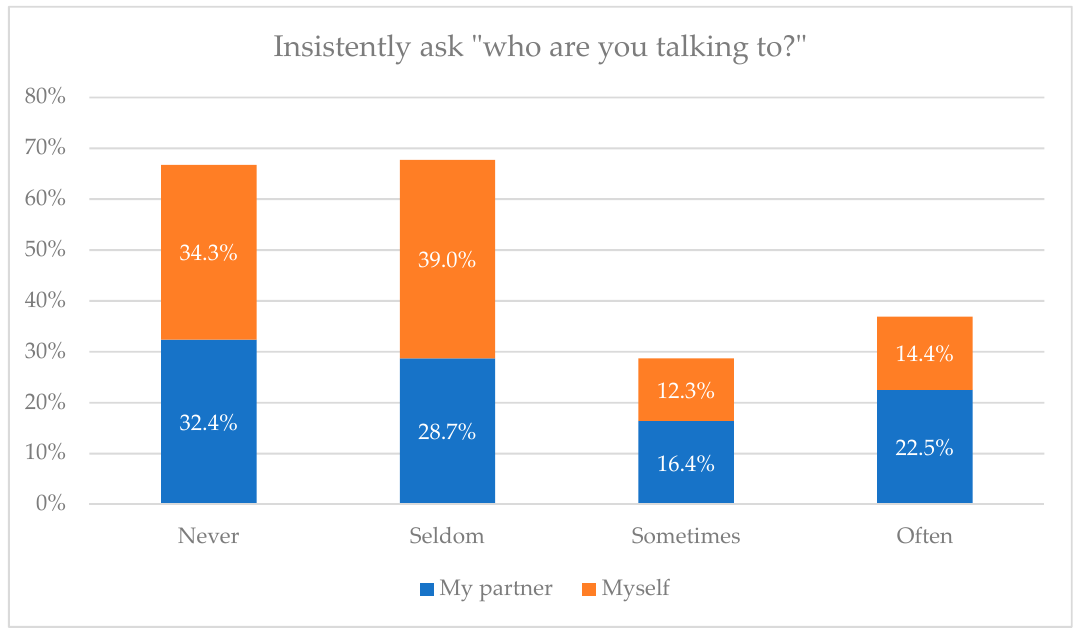
Figure 2. Results for item 13 on affective–sexual relationships according to the participant. Item 15, on looking at the movements of the partner in their networks and